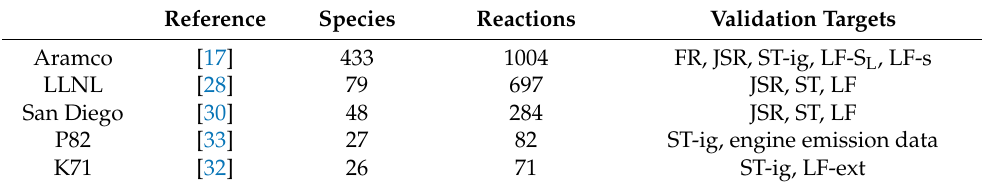
Table 1. Reaction mechanisms. Abbreviations of validation targets: first part indicates experimental configuration (JSR—Jet Stirred Reactor, ST—Shock Tube, FR—Flow Reactor, LF—Laminar Flame); second part is type of data (ig—ignition delay time, S L —laminar burning velocity, s—speciation, ext—extinction strain rate). The San Diego, LLNL and Zhao290 reaction mechanisms use